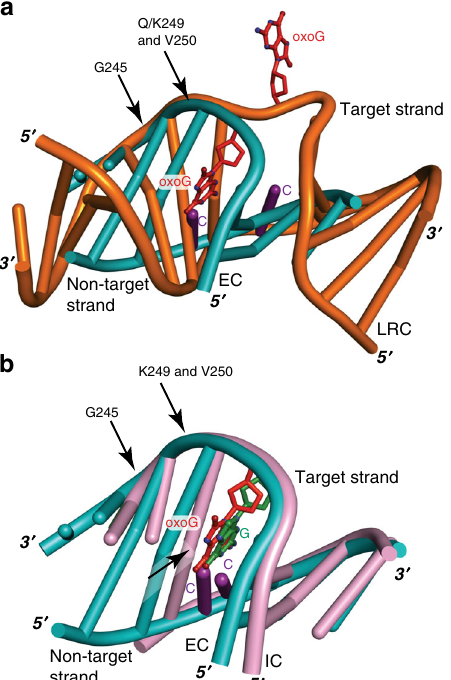
Fig. 3 Comparison of the DNA conformations between the sequence- matched xLRC, EC, and IC. Signature helix-hairpin-helix motif residues G245, Q/K249, and V250 that interact with DNA through backbone amide, common to all hOGG1 – DNA structures solved to date, are denoted by an arrow. DNA base-pairs are shown as orange ladders in xLRC, teal ladders in EC, and pink ladders in IC. The target base is shown as sticks (red: oxoG; green: G) and estranged cytosine is labeled as purple. a Superposition of xLRC with EC. The DNA trajectory of the 5 ′ end of the target strand and the entire non-target strand is strikingly different between EC and xLRC structures. b Superposition of EC with IC. In both structures, the target strand remains in the same position with respect to hOGG1, but the non- target DNA strand of the IC structure has translocated by half a nucleotide step toward the 3 ′ end of the non-target strand, marked with an